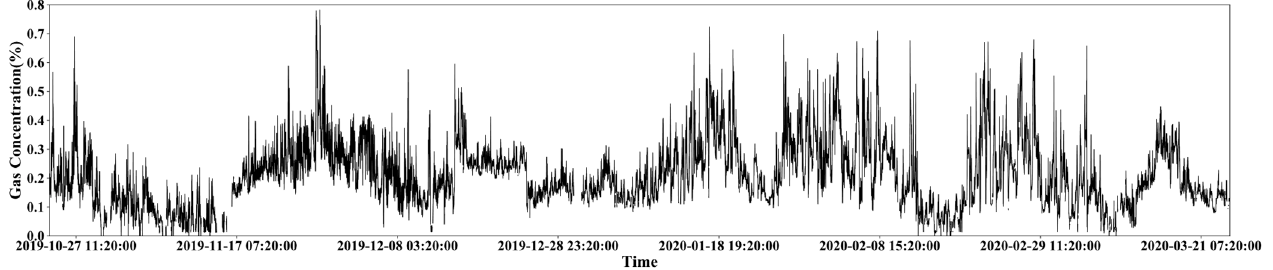
Figure A1. Variation trend of gas concentration in D2 data set.